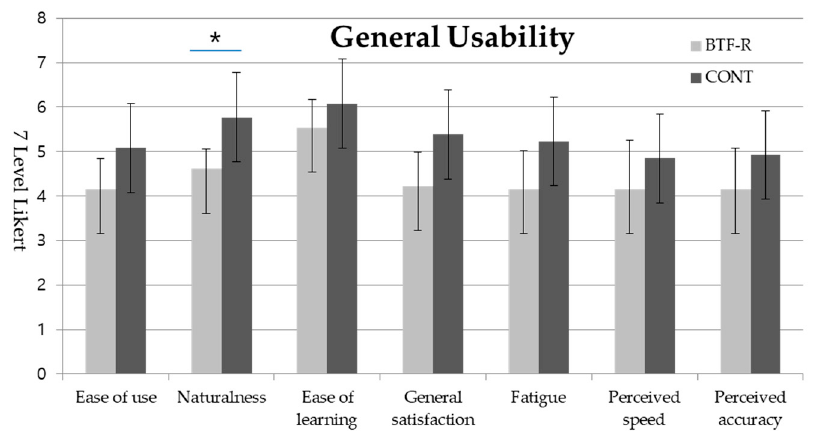
Figure 14. Responses to the usability survey for selecting objects with sizes below 0.4 cm between BTF-R and CONT. The asterisk mark (*) indicates statistically significant difference.